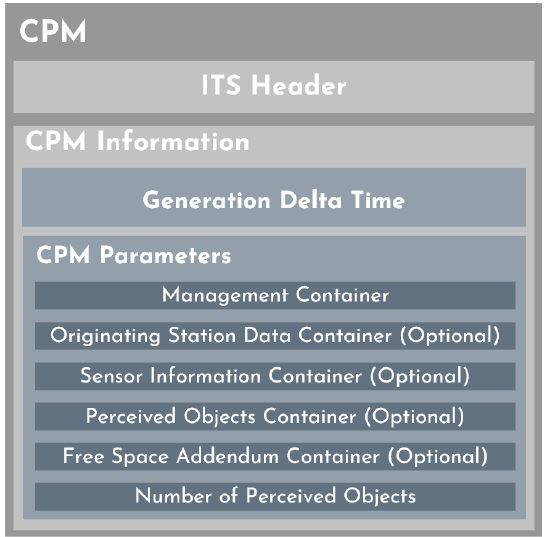
Figure 1. ETSI collective perception message (CPM) general structure